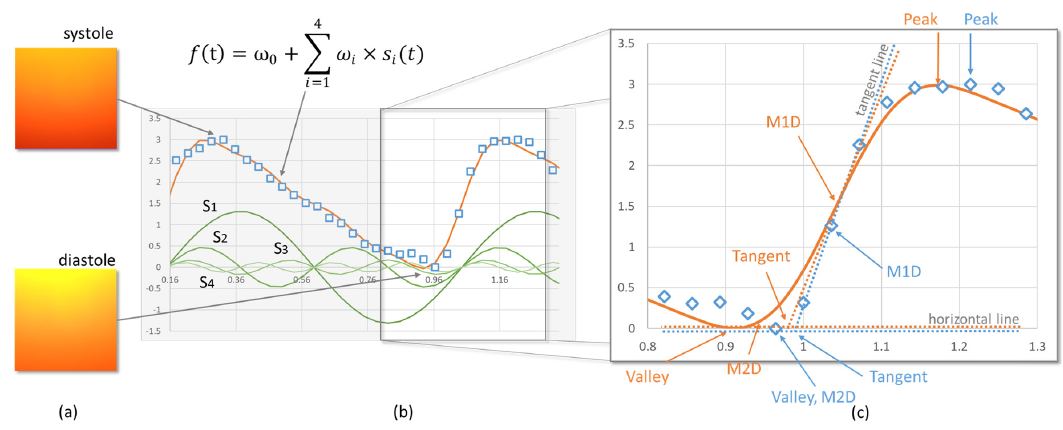
Figure 2. ( a ) Illustration of two frames of the video of a left fingertip captured using a smartphone camera (Mi 8 SE, Xiaomi, China). The frame captured during the systole phase is darker and converted to a larger value by photoplethysmography (PPG); the frame captured during the diastole phase is lighter and converted to a smaller value by PPG. ( b ) Illustration of using the sum of the four sinusoidal functions to fit the collected samples from a 19-year-old female. ( c ) Illustration of five types of fiducial points (Peak, Valley, Tangent, maximum first derivative (M1D), and maximum secondary derivative (M2D)) determined with both raw data points (blue) and the fitted model (orange).